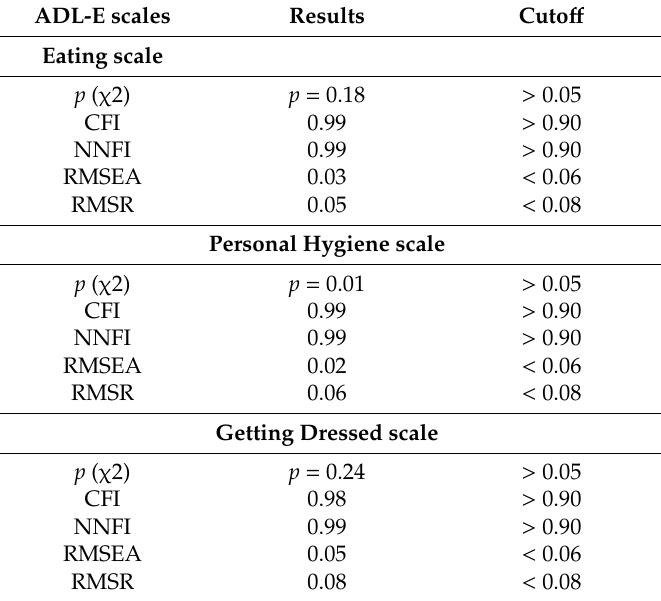
Table 13. ADL-E goodness-of-fit